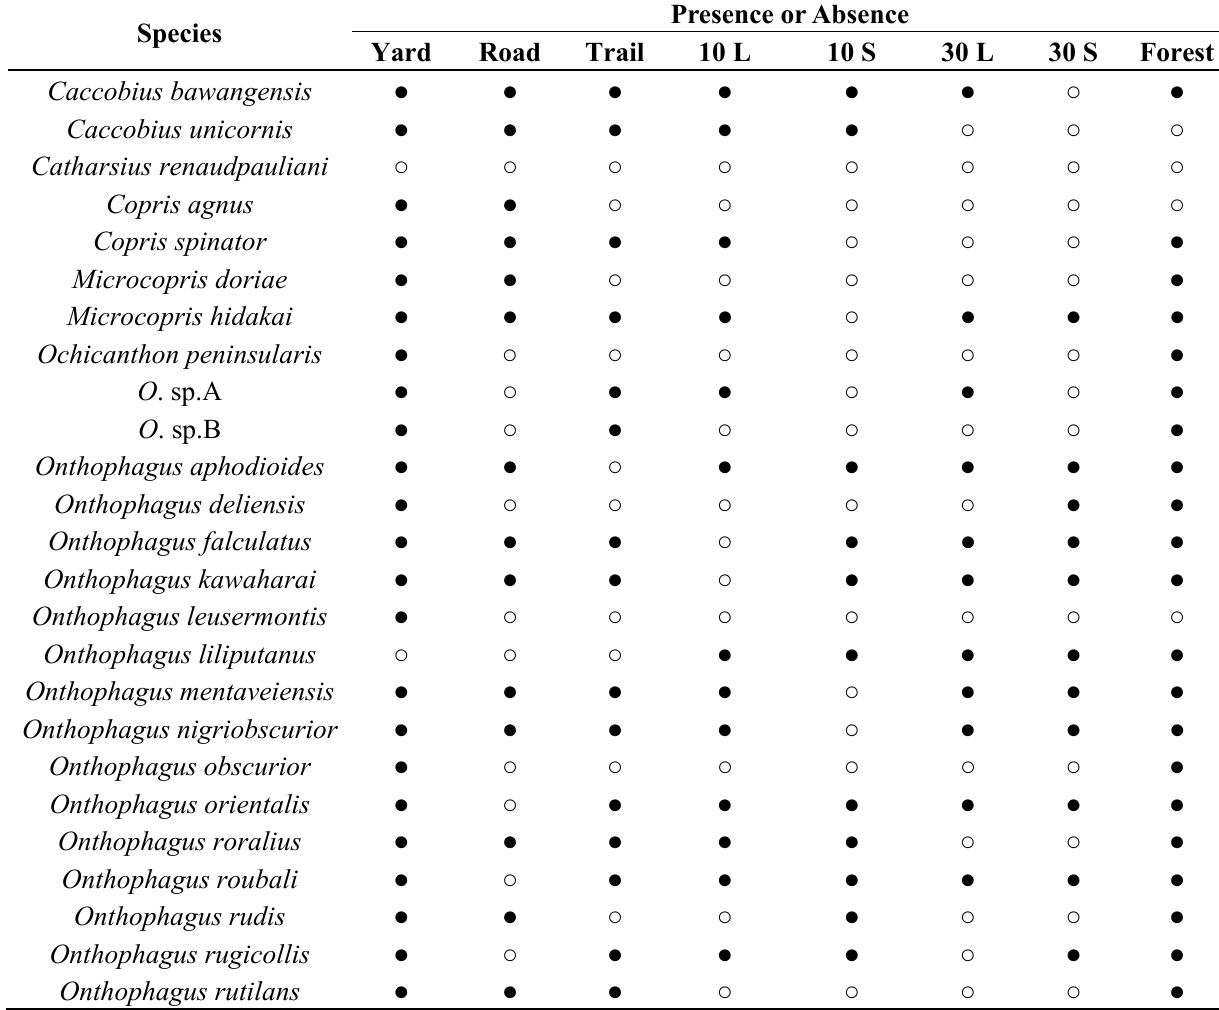
Table 2. Dung beetle species trapped in block 5 of Temengor Forest Reserve, Perak, Malaysia. Dung beetle species which appeared in eight sites are denoted by open circles and those which did not appear are by closed circles in the presence or absence columns. “Yard,” “Road, and Trail” indicate pitfall traps at log-yards, logging roads, and at skid trails, respectively. 10 L, 30 L, 10 S, 30 S and Forest represent forests at 10 m or 30 m from logging roads, forest at 10 m or 30 m from skid trails and forests at 60 m from logging roads and skid trails,